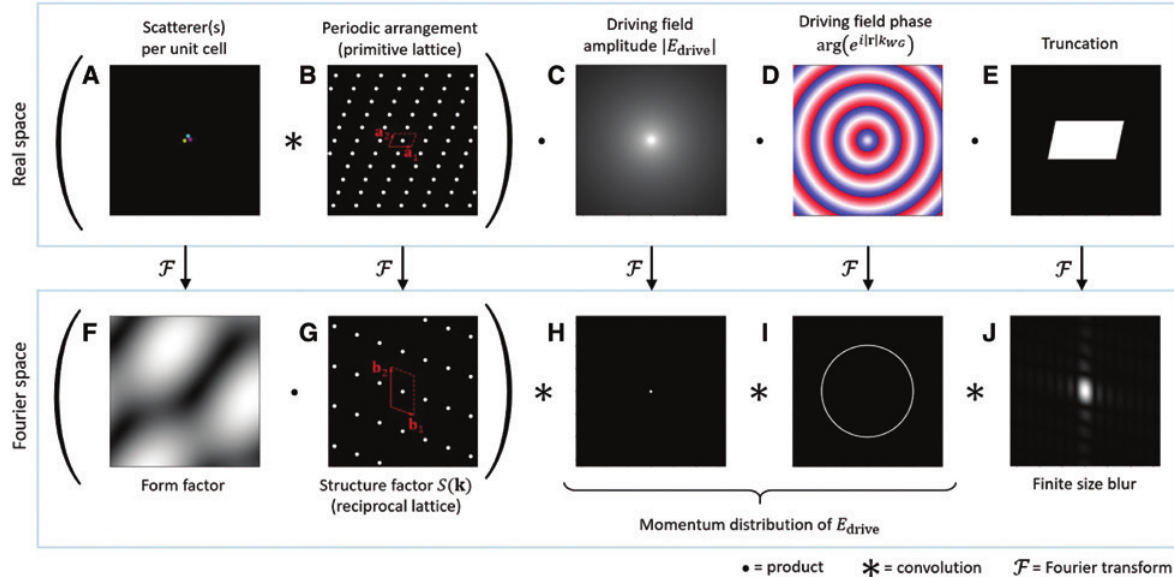
Figure 3: Shaping the metasurface emission pattern: real-space factors (A–E) and their effect in the momentum space (F–J). (A) Distribution of scatterers within the lattice unit cell. Each of these scatterers can have different polarizability α , including amplitude, bare phase, and symmetry of the response to electromagnetic field. When all scatterers are repeated by lattice vectors [read arrows (a and a ) 1 2 in (B)], each of them forms a separate primitive sublattice, which is then overlaid with other sublattices, forming a complex geometrical arrangement. (B) Periodic arrangement (primitive lattice) of unit cells, common for every sublattice. (C) Spatial distribution (in log scale) of optical field amplitude generated by a single light emitter. (D) Phase distribution of the same field, governed by the propagation constant ( k ) of the guided mode of luminescent layer. (E) Truncation of the system. (F) Effective form factor: far-field envelope due to WG the interference of form factors of individual scatterers – unit cell constituents. This factor also encodes the polarization dependence. (G) Structure factor: reciprocal lattice (with the k -space unit cell spanned by vectors b and b ), showing all possible diffracted orders, some of 1 2 which become evanescent as a result of having momentum larger than that of the free space radiation. (H–I) Momentum distribution of the single emitter optical field E , forming a circle of radius k . (J) Momentum blur caused by truncation (finite size) of the drive WG